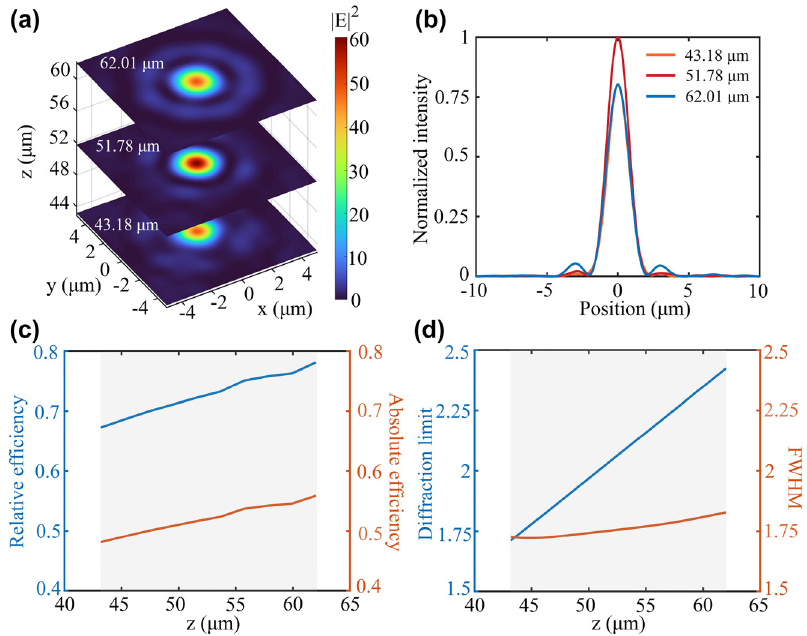
Figure 3: Optical field distribution over DOF range. (a) Electric field distribution in xoy plane at different locations in DOF (minimum, focal point, and maximum). (b) Normalized intensity distribution along the x -direction in DOF (minimum, focal point, and maximum). (c) Ef fi ciency variation during DOF. (d) Diffraction limit and FWHM variations during DOF. The gray areas in (c) and (d) indicate the range of